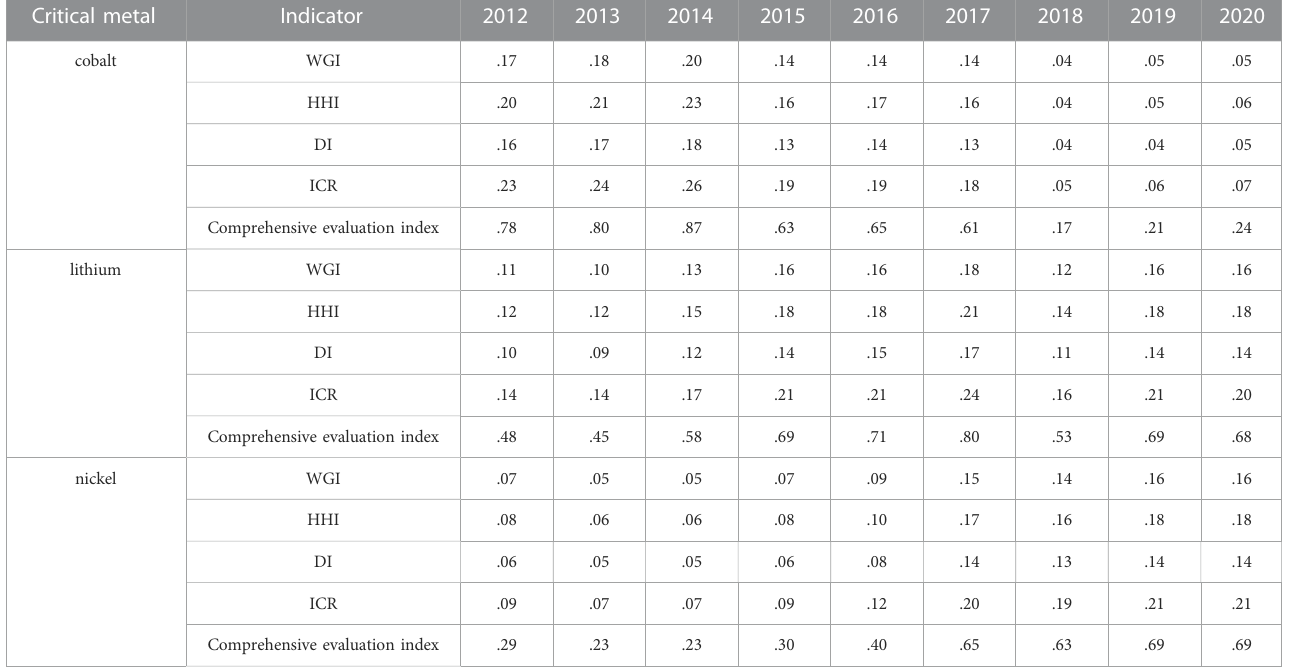
TABLE 8 The results of the comprehensive evaluation of the supply risk of cobalt, lithium, and nickel resources in China. Critical